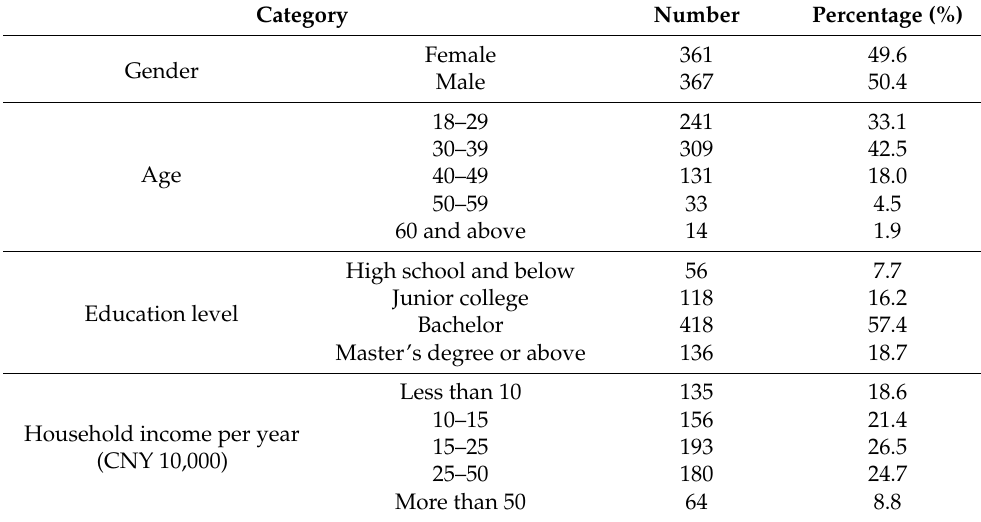
Table 2. Demographic profile of